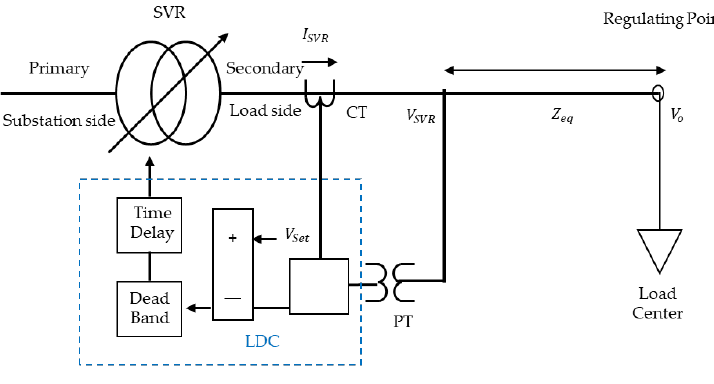
Figure 2. Operation Structure of LDC.